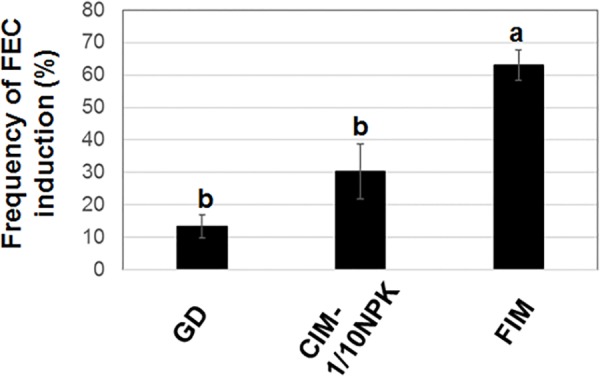
Effect of FIM on FEC production.FECs were induced on GD media, CIM-Ρ NPK and FIM. Means and standard deviation were represented as three independent measurements as shown in S7 Table. CIM-Ρ NPK was composed of CIM in which nitrogen, phosphate, and potassium was reduced. FIM was composed of CIM in which nitrogen, phosphate, and potassium was reduced and 10 mg/L vitamin B1 was added. Values labeled with different letters (a and b) at all conditions are significantly different by Scheff’s multiple comparison tests at P<0.05.